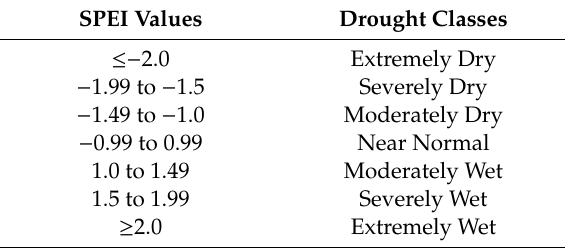
Figure 5. SPEI variation for two major droughts, ( a ) 1937–1945 (World War II Drought) and ( b ) 2001–2010 (Millennium Drought). Table 1. Drought classification according to Standard Precipitation Evaporation Index (SPEI) index